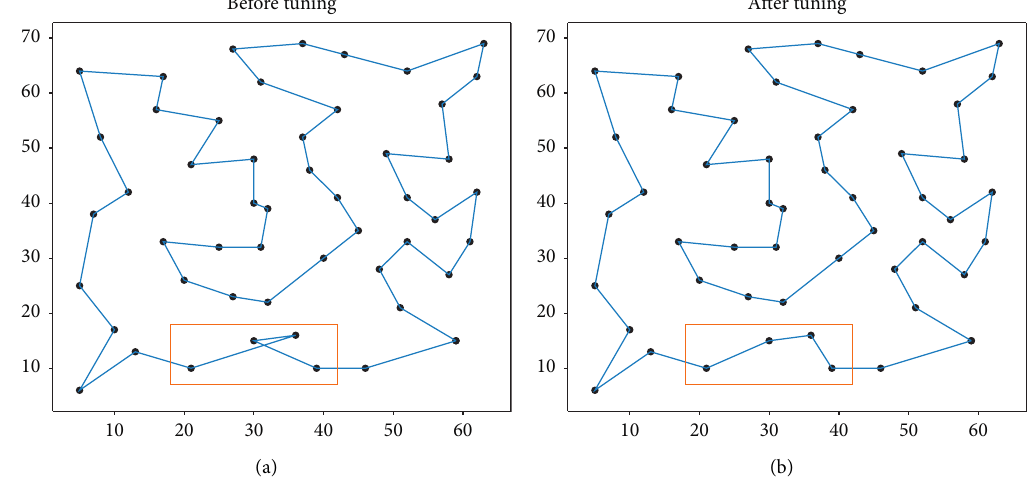
Figure 4: Local optimization. (a) Before tuning. (b) After